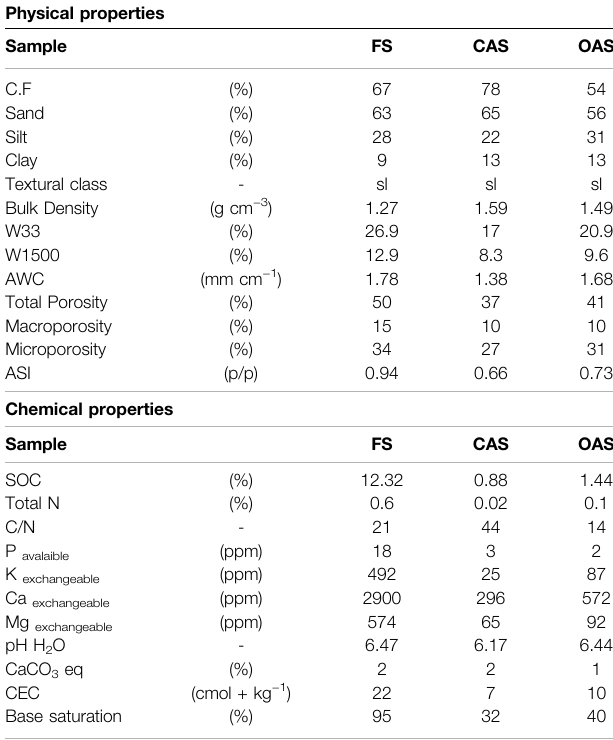
TABLE 1 | Soil physical and chemical properties of